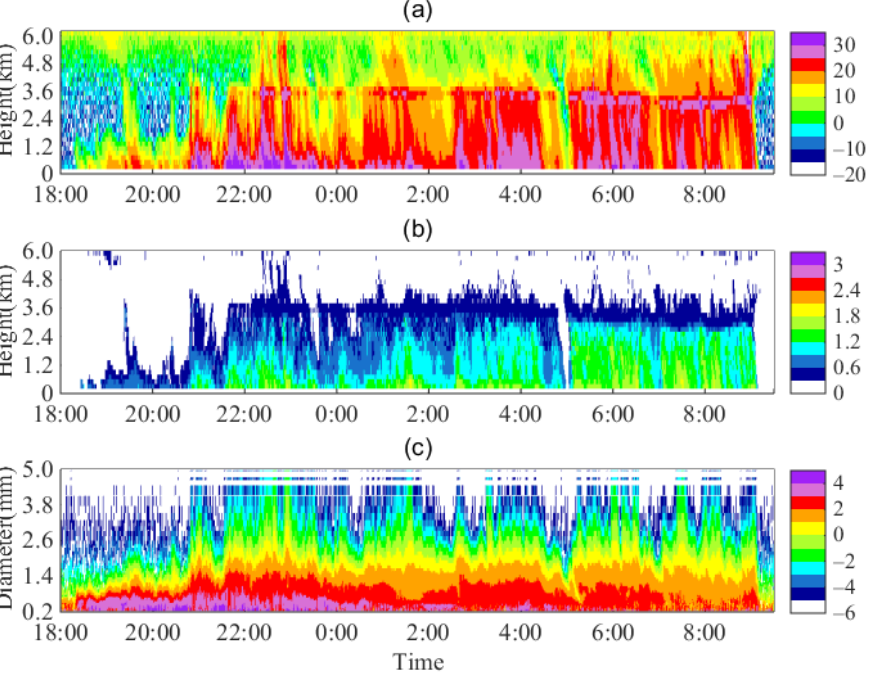
Figure 8. Time–height cross-sections of stratiform rain detected by MRR from 18:00 on 18 August 2021 to 9:30 on 19 August 2021: ( a ) reflectivity factor Z (dBZ), ( b ) mass-weighted mean diameter (mm) and ( c ) DSD at 400 m.